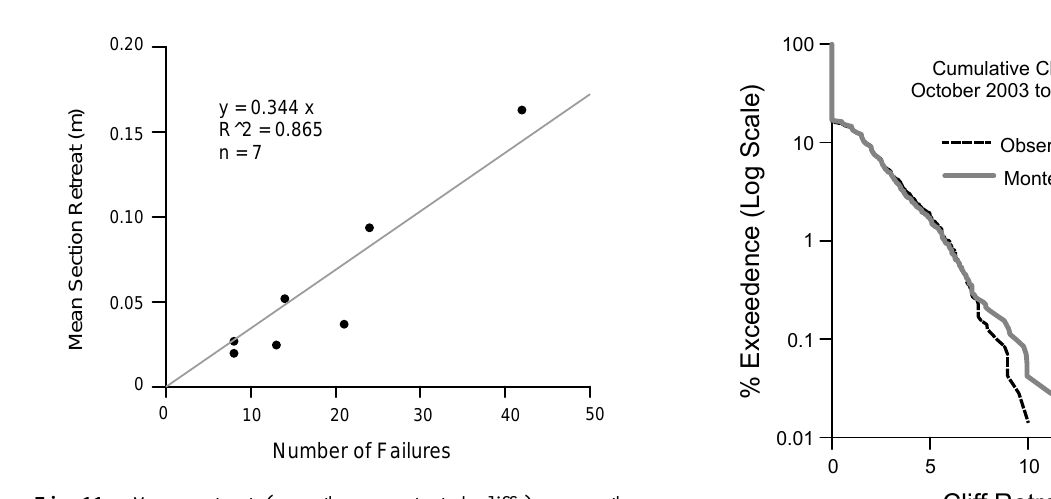
Fig. 11. Mean retreat (over the unprotected cliffs) versus the number of failures during each time interval.